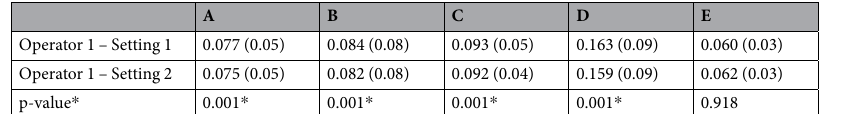
Table 3. Congruence of reference areas in the two different settings. Values represent median (interquartile range) of mean absolute distance (MAD) between corresponding reference areas (A, B, C, D, or E) used each